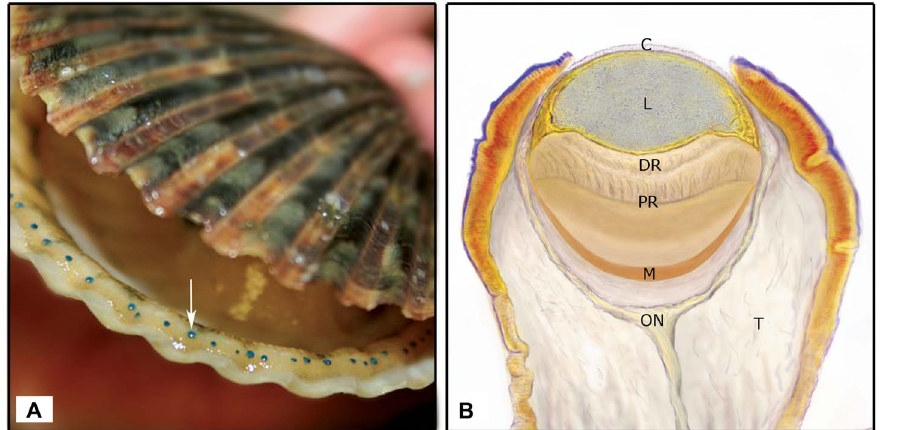
Figure 1. The mirror type eye of the scallop Argopectenirradians. ( A ) Scallops have up to 200 single chambered eyes along their mantle edge, indicated by the white arrow. ( B ) The eye sits on a tentacle (= T) and the major internal structures of the scallop eye are indicated. C= cornea, L= lens, DR= distal retina, PR= proximal retina, M= mirror, ON=optic nerve.